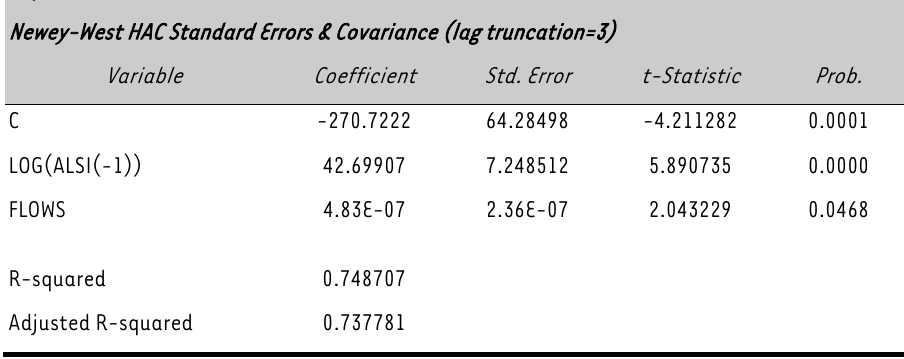
TABLE 2: Regression results for the equity component Dependent Variable: COIN